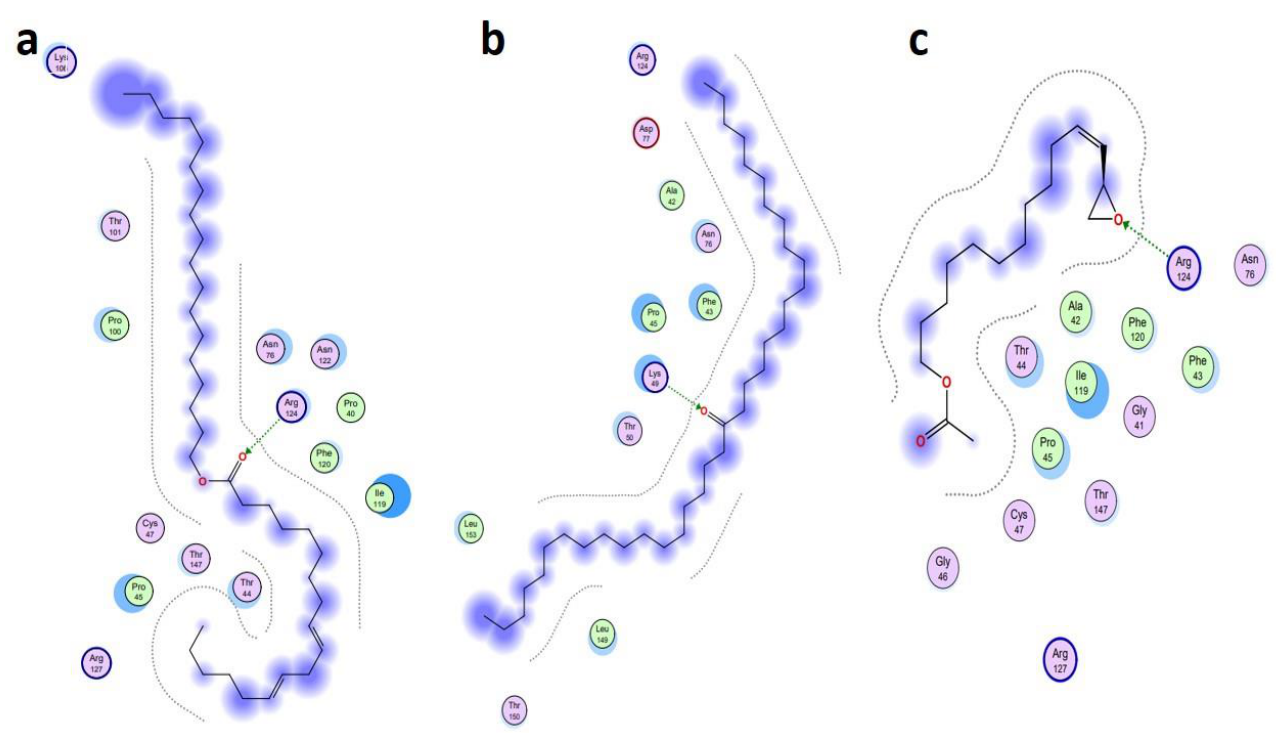
Figure 7. Interaction plot of top three scored docked ligands CID_ 22287839 ( a ), CID_10440 ( b ), and CID_ 5363633 ( c ), within active site of antioxidant protein [PDB ID: 1HD2], in the vicinity of 4Å.